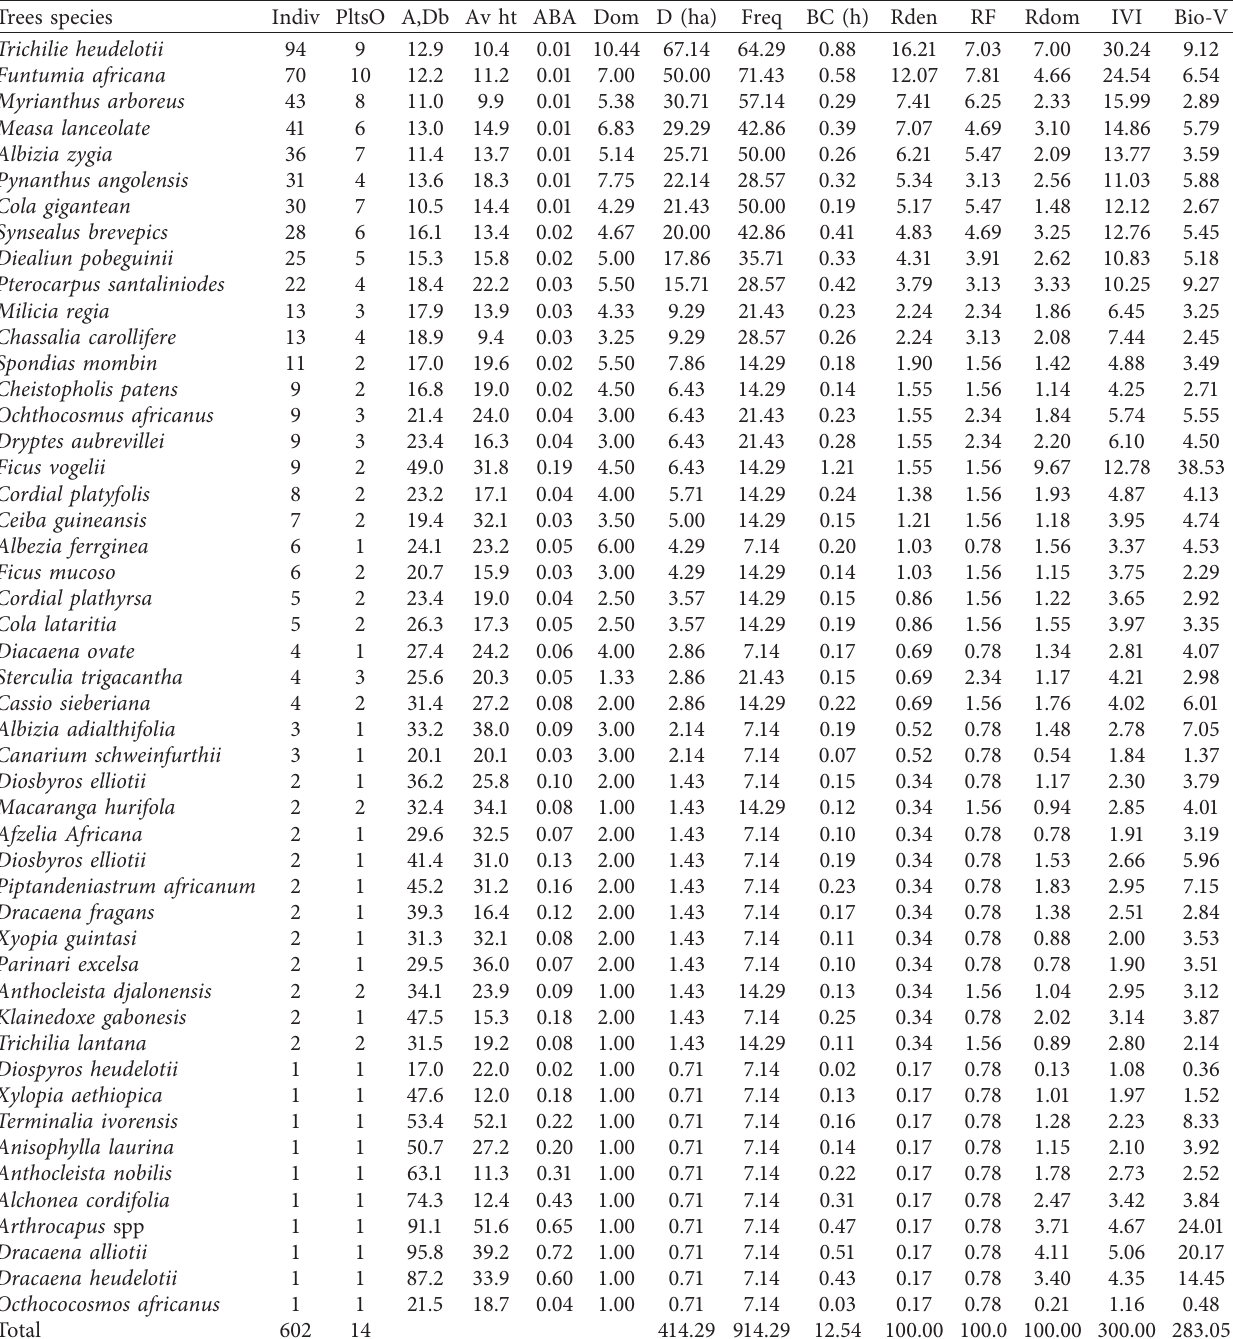
Table 1: Species composition parameters and